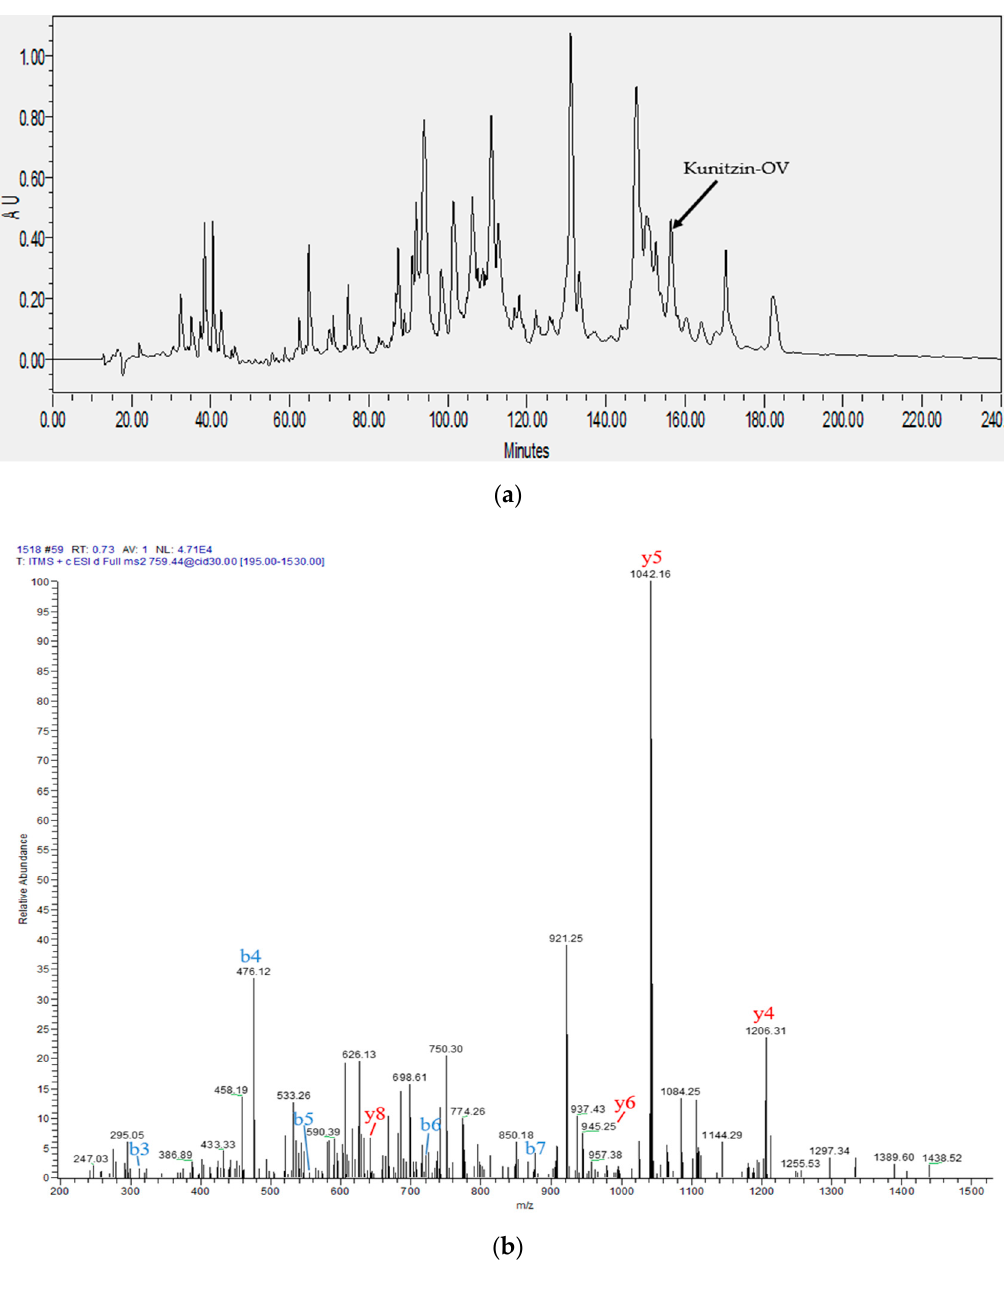
Figure 3. The identification and characterisation of Kunitzin-OV: ( a ) the 240 min reverse-phase high-performance liquid chromatography (HPLC) chromatogram of the skin secretion of Odorrana versabilis . The elution position is indicated with an arrow. The components were monitored at a wavelength of 214 nm; ( b ) peptide fragment spectrum collected on an LCQ Fleet ion trap mass spectrometer. The peptide was fragmented randomly at each peptide bond, b- and y-ions are indicated in blue and red.